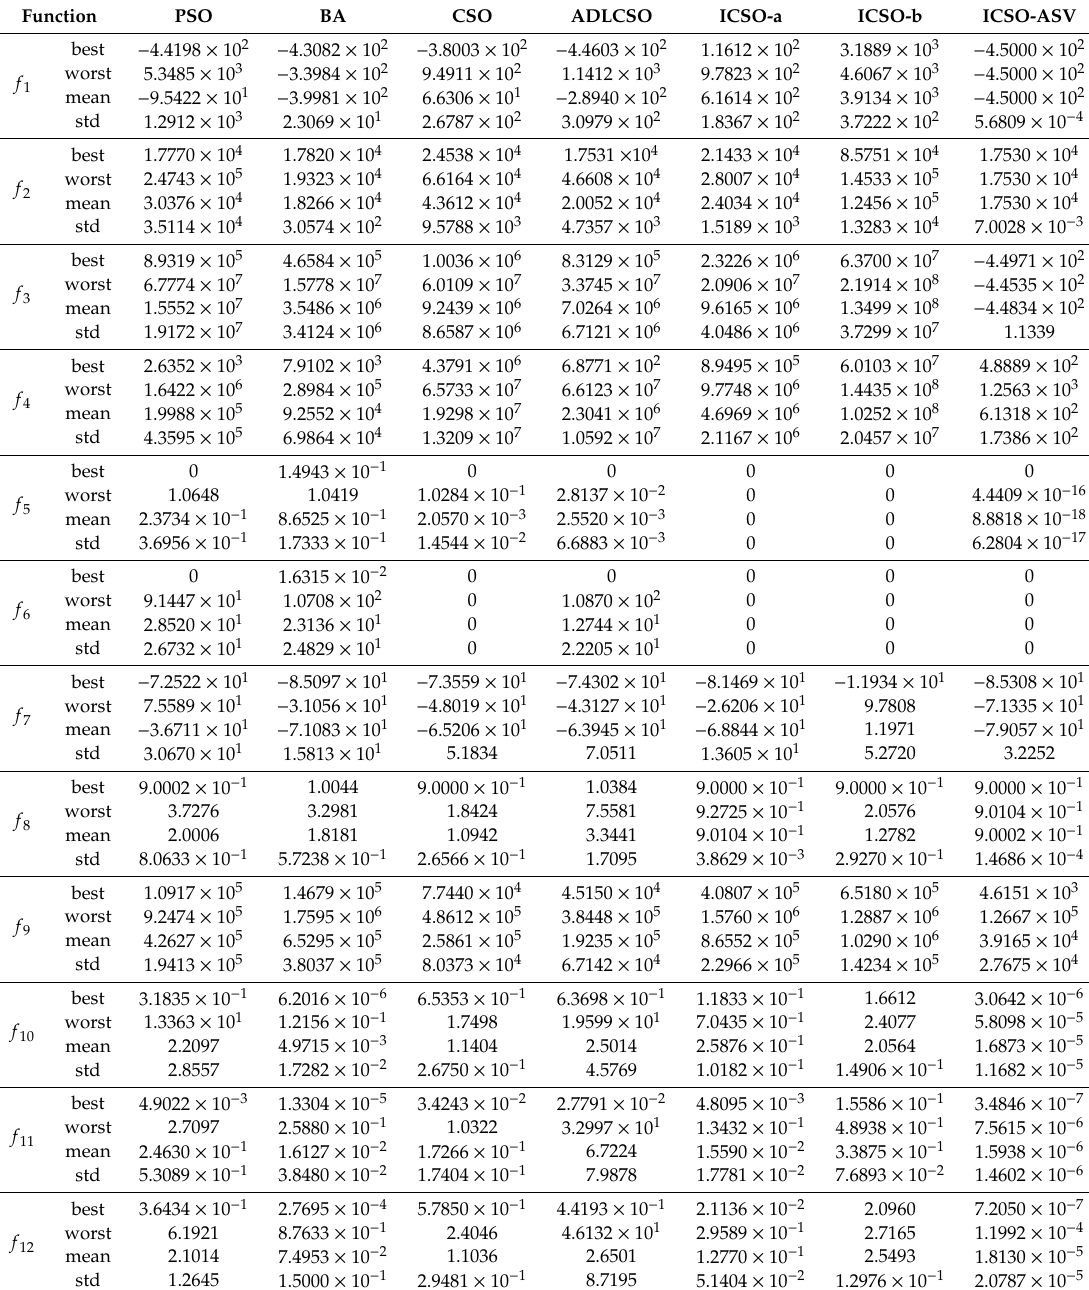
Table 3. Solution results for the 30D benchmark test